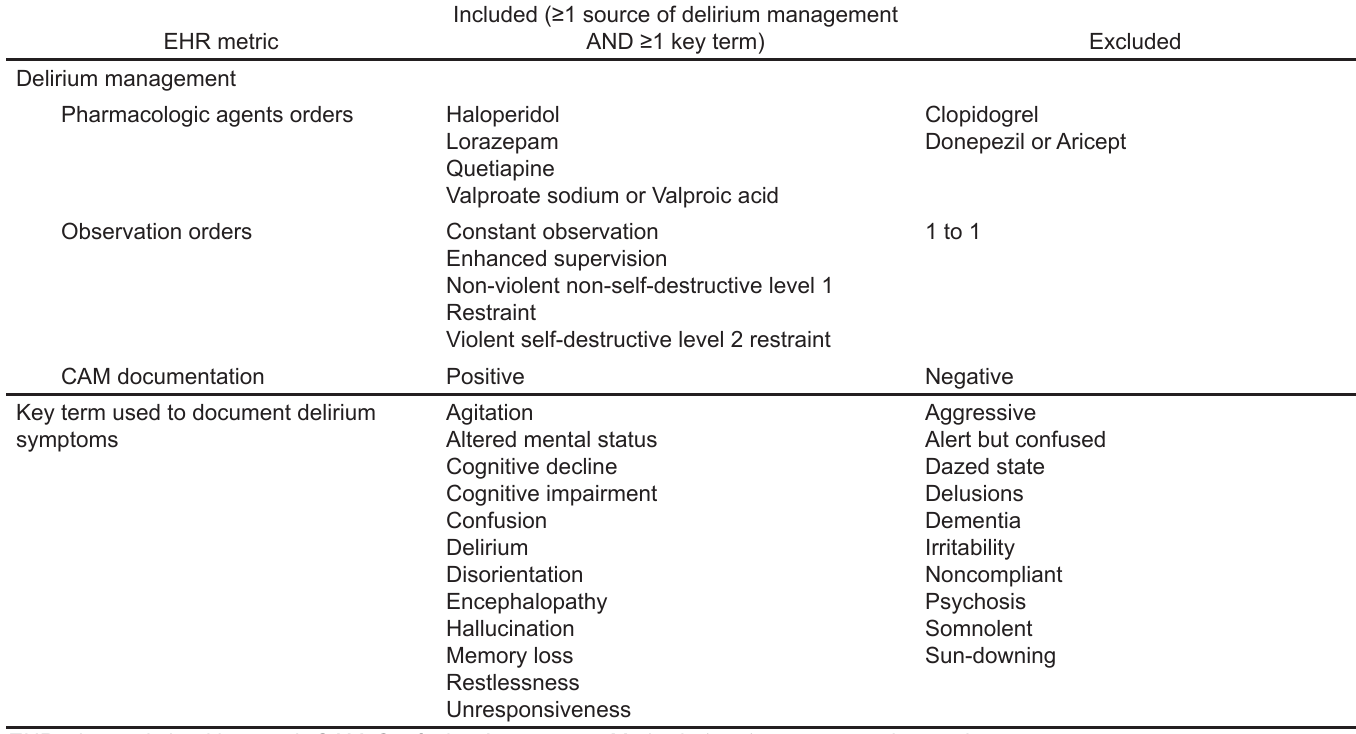
Table 1. Metrics used to identify delirium in electronic health record